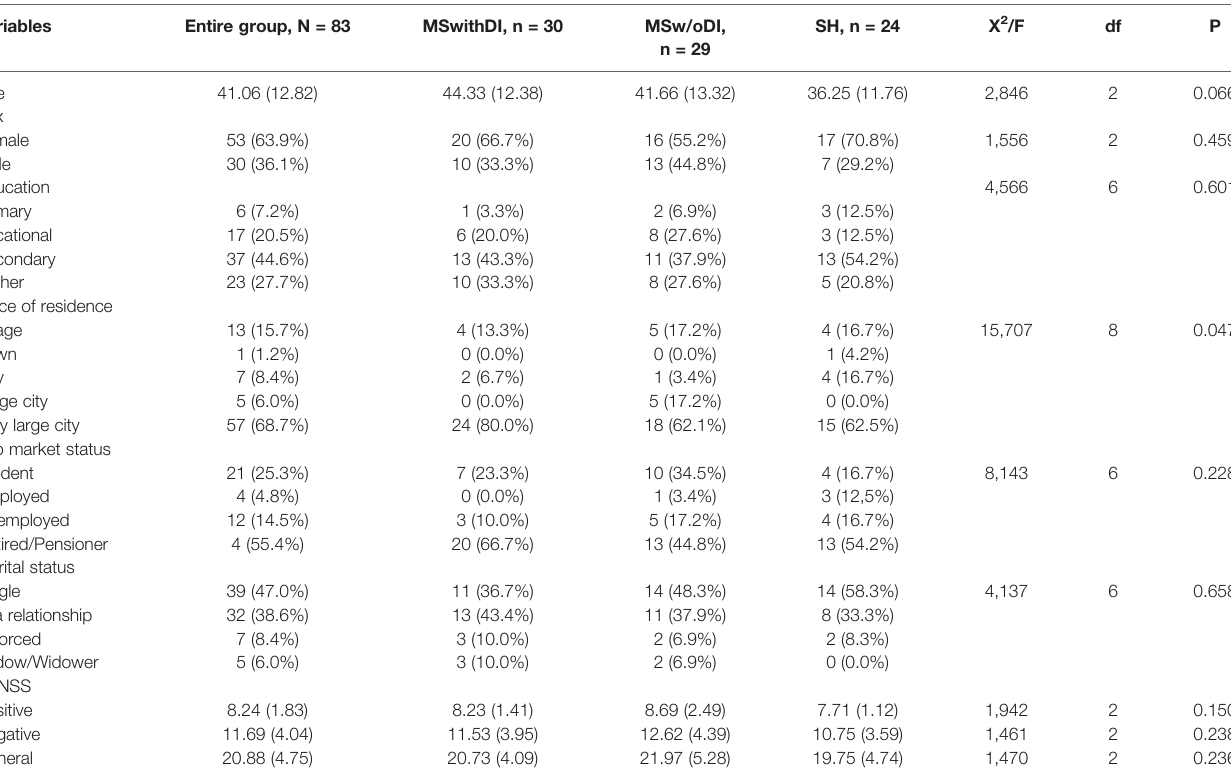
TABLE 1 | Sociodemographic characteristics of groups studied, N(%) or M(SD). Variables Entire group, N =